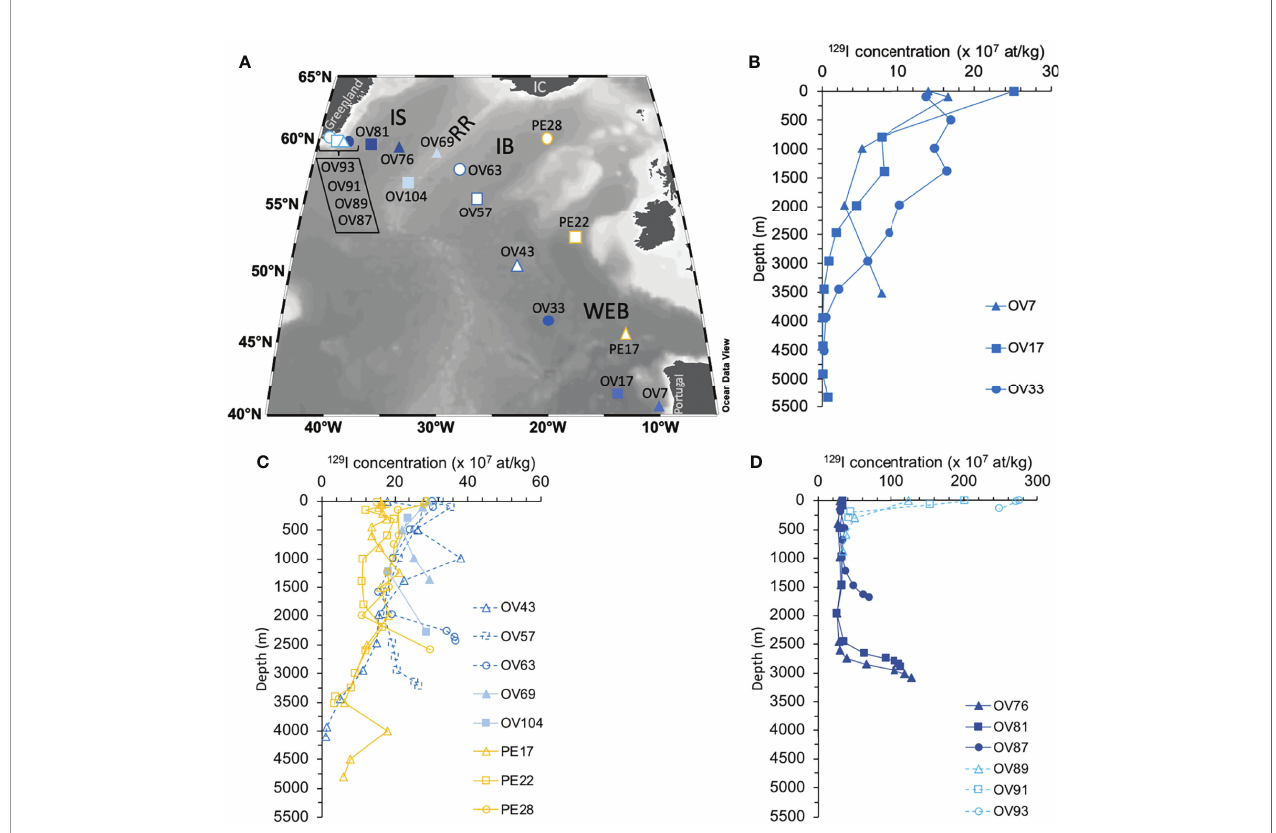
FIGURE 2 | (A) Map of 129 I depth pro fi les displayed from (B) low-, (C) mid-, to (D) high- concentrations. The legends include all stations sampled during the PE424 cruise in 2017 (PE) and the OVIDE cruise in 2018 (OV). Acronyms in fi gure: Iceland Basin, (IB); Iceland, (IC); Irminger Sea, (IS); Reykjanes Ridge, (RR); and West European Basin,